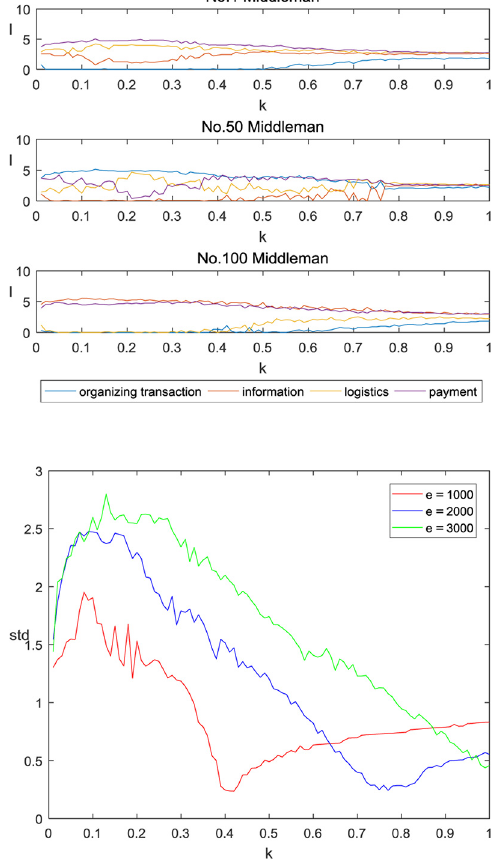
Figure 13. Uncorrected sample standard